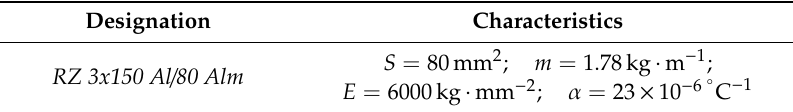
Table 7. Characteristics of cable RZ 3x150 Al / 80 Alm .